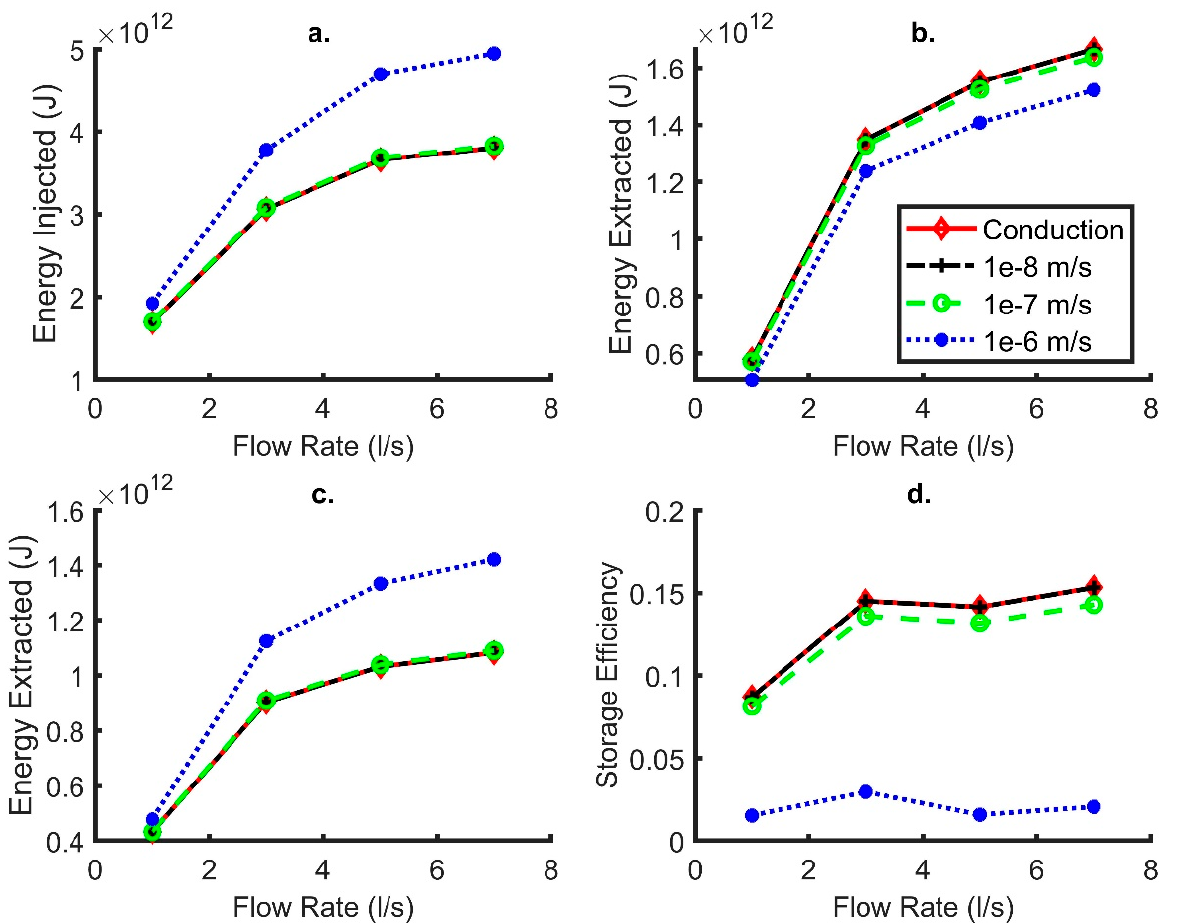
Figure 11. The impact of varying the DBHE internal fluid circulation rate during a 6 month heat charge cycle, followed by a 6 month discharge cycle. Inlet temperature during charge was maintained constant at 95 ◦ C during charge and 5 ◦ C during discharge. ( a ) energy injected during charge, ( b ) energy extracted during discharge cycle following charge, ( c ) energy extracted during 6 month discharge period without preceding charge and ( d ) storage efficiency calculated according to Equation (10).